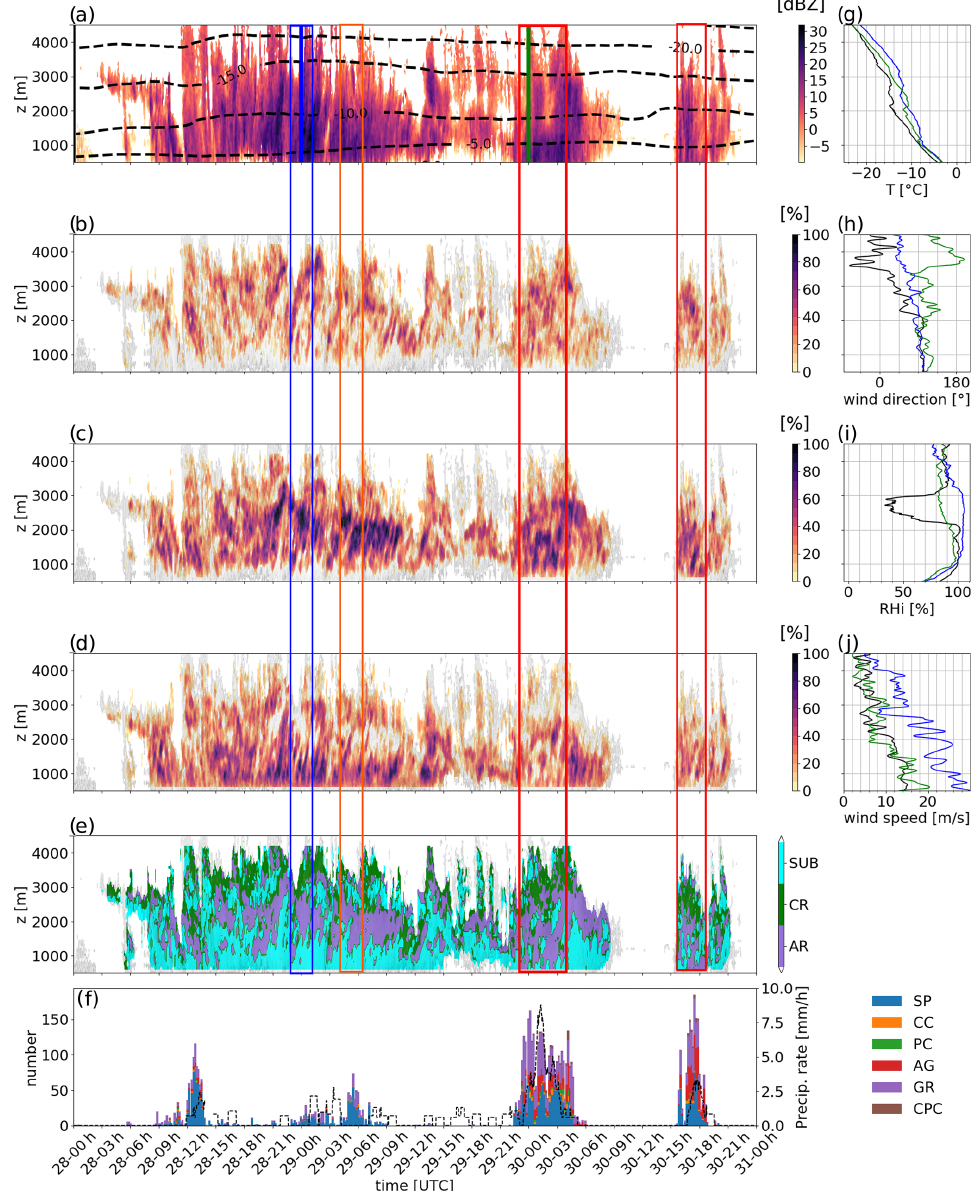
Figure 3. Time–height plot of Z H (a) and of the process identification from the PIVS method during EV1 with (b) CR, (c) AR, (d) SUB and (e) the three categories. In panels (b–e) , the gray shading indicates regions where Z H > − 15dBZ. The dashed black lines in panel (a) show the temperature isotherms from the corresponding WRF simulation (extracted and averaged along the same RHI scan). The color bar in panels (b–d) refers to the percentage of gates at a given height within the RHI corresponding to a certain process. In panel (e) , the color labeling indicates the dominant microphysical process. On the y axis, z is the altitude above ground level. Panel (f) presents the time series of the cumulative number of hydrometeors – classified into different categories, following Praz et al. (2017) and detected by the MASC. SP, CC, PC, AG, GR and CPC refer to small particles, columnar crystals, planar crystals, aggregates, graupel and combination of planar and columnar crystals, respectively. The black dashed line shows the precipitation measured at the surface with a snow gauge. Panels (g–j) show the radiosounding measurements, which are, respectively, temperature, wind direction, relative humidity with respect to ice (RHi) and wind speed. The colors of the profiles refer to different times indicated with thick vertical lines in panel (a) . The red boxes delimit time periods during which aggregation is detected down to the ground by PIVSs and aggregates, and graupel are detected in a relatively high proportion (half of particles) by the MASC. The blue box indicates a period with at simultaneous intense reflectivity in the column and intense near- surface sublimation associated with few particles at the ground level. The orange box, a few hours later, shows when SUB weakens and when more particles are detected by the